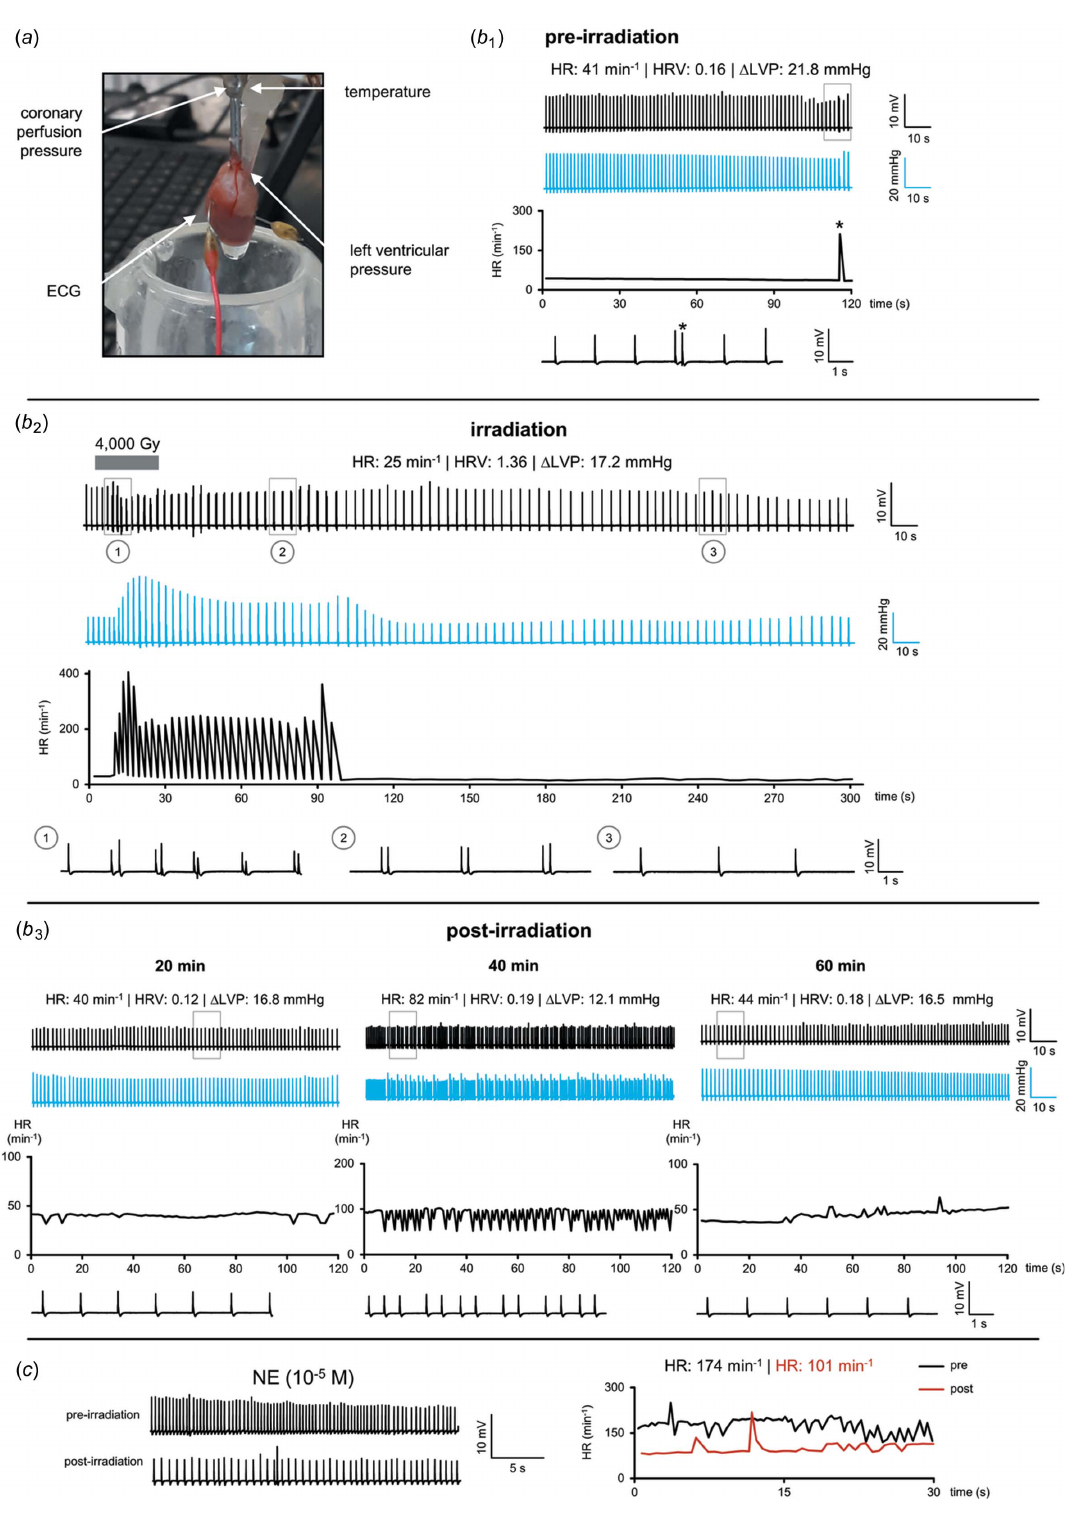
Figure 3 ( a ) Setup of the Langendorff heart, recording coronary perfusion pressure, temperature, electrocardiogram (ECG) and left ventricular pressure. ( b 1 ) ECG (black traces), left ventricular pressure (blue traces), time course of the heart rate (HR) and enlarged ECG during baseline before irradiation (HR; HRV: heart rate variability; (cid:2) LVP: change in left ventricular pressure). ( b 2 ) ECG (black traces), left ventricular pressure (blue traces), time course of the heart rate (HR) and enlarged ECG during irradiation and early post-irradiation. A transient increase of left ventricular pressure was observed in this phase. ( b 3 ) ECG (black traces), left ventricular pressure (blue traces), time course of the HR and enlarged ECG at different post-irradiation time points. The heart rate completely returned to pre-irradiation baseline values within 60 min after MBI. ( c ) NE challenge ECG before and after irradiation (left) and heart rate (right). Norepinephrine (NE) still increased the heart rate after 1030 Elisabeth Schu¨ltke et al. (cid:5) Modification of the Langendorff system J. Synchrotron Rad. (2022). 29 , 1027–1032